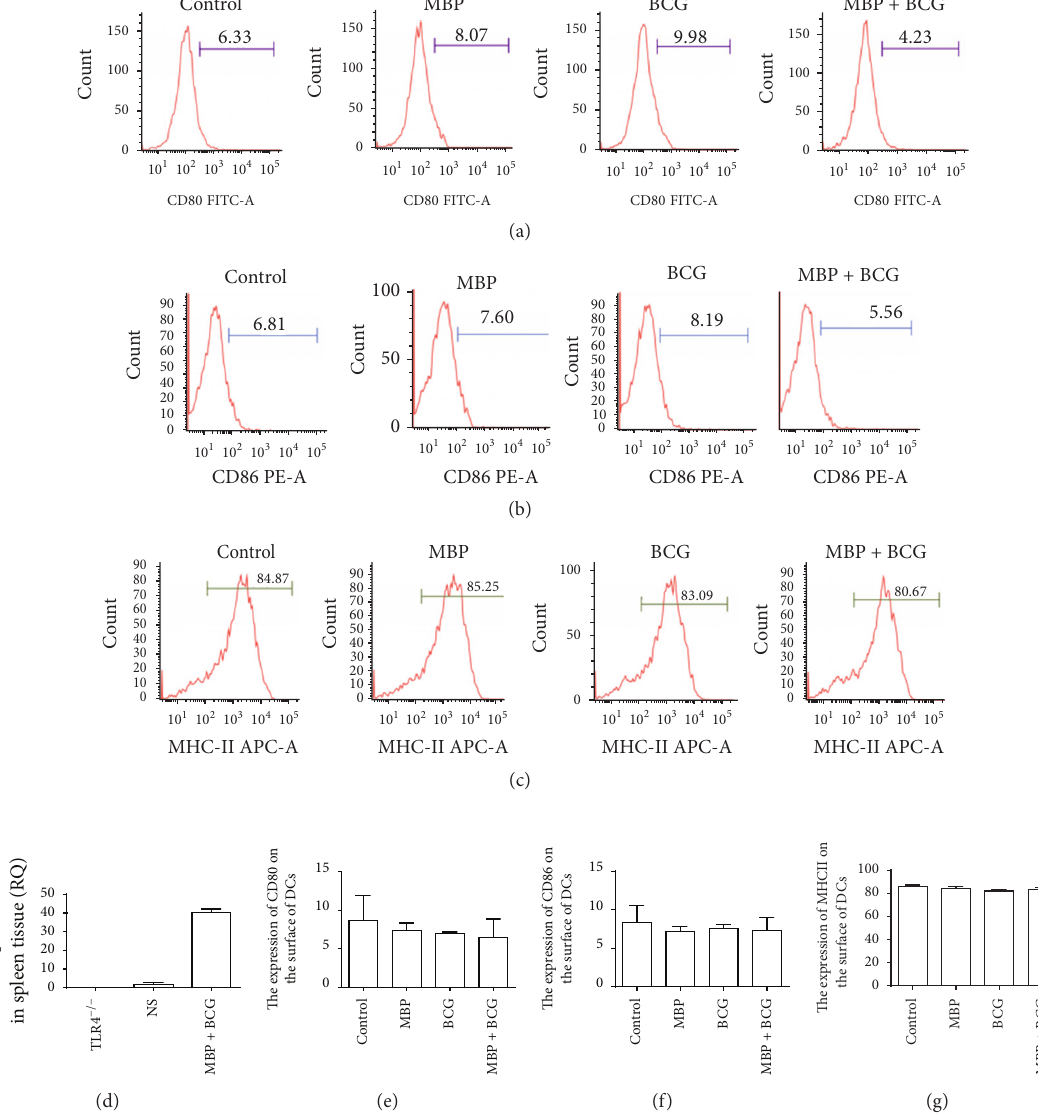
Figure 4: Effect of the combination of MBP and BCG on the phenotypic maturation of DCs from TLR4 −/− mice. Splenic DCs from TLR4 −/−